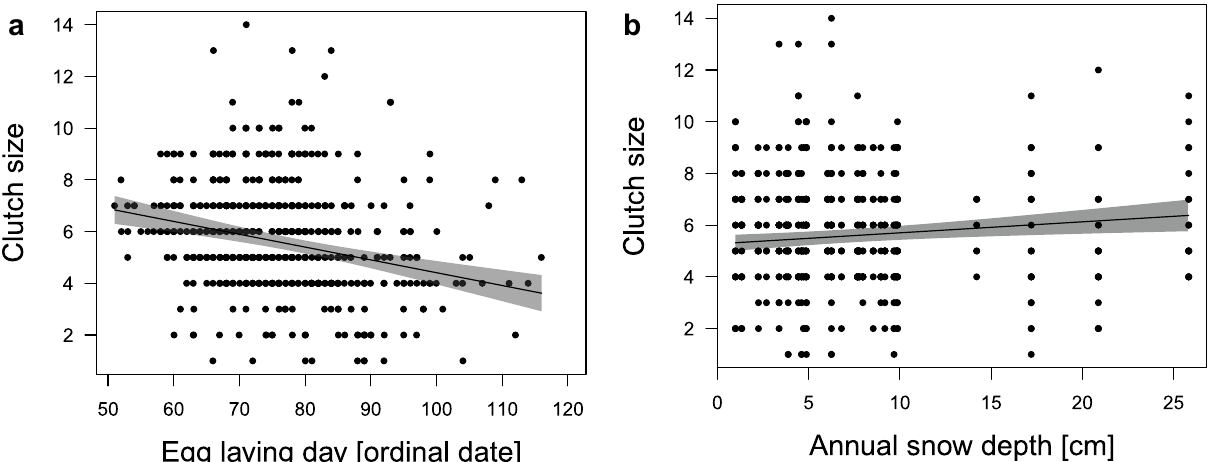
Figure 6. Relationship between clutch size and ( a ) the timing of breeding and ( b ) annual snow depth. Earlier clutches had more eggs (estimate − 0.26 ± 0.05, − 0.357 LCI − 0.156 UCI) and higher snow cover was associated with larger clutch sizes (estimate 0.12 ± 0.04, 0.037 LCI 0.202 UCI) in greylag geese in the Alm valley, Austria, between 1990 and 2018. Lines are the predicted relationships based on the output of the LMM (Table 4), with 95% CIs in shaded grey. Background scatter represents raw data (n = 559 breeding records with known clutch sizes of 145 individual females over 29